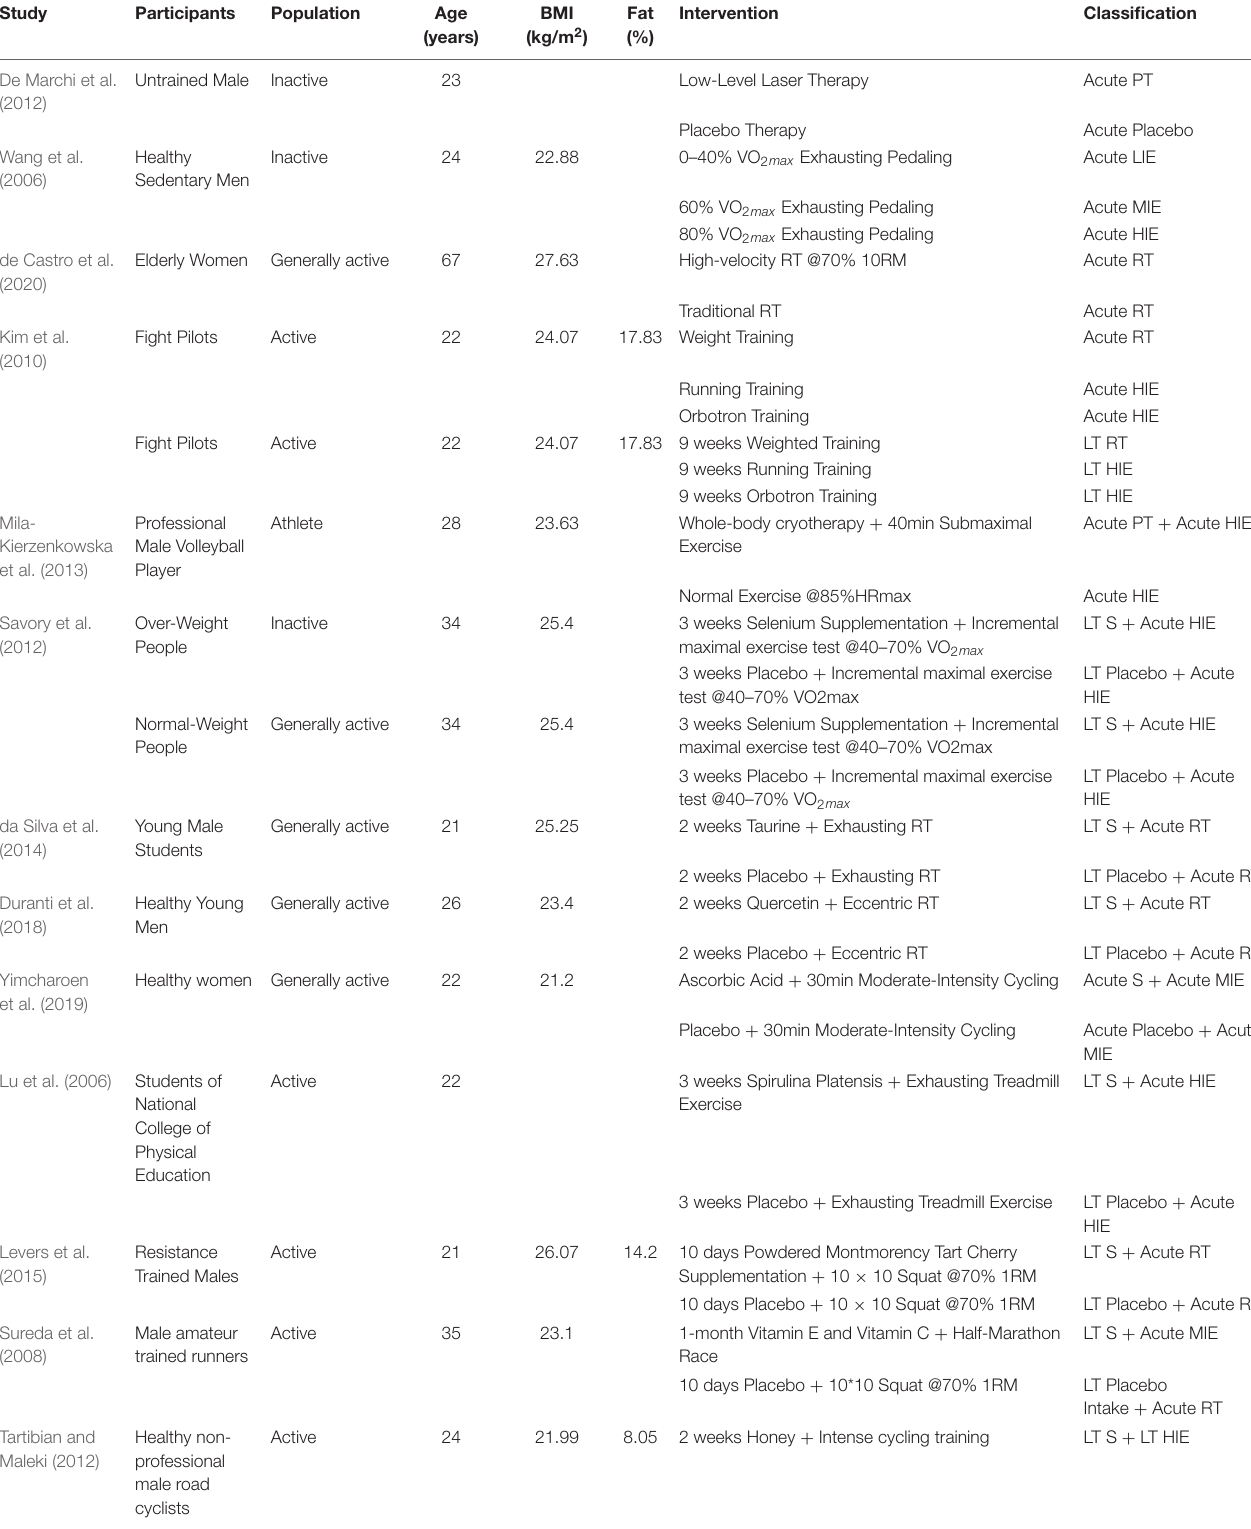
TABLE 1 | Information of the included studies explored the effect of different supplementation and physical exercise protocols on the increasing plasma superoxide dismutase (SOD) after exercise tests.